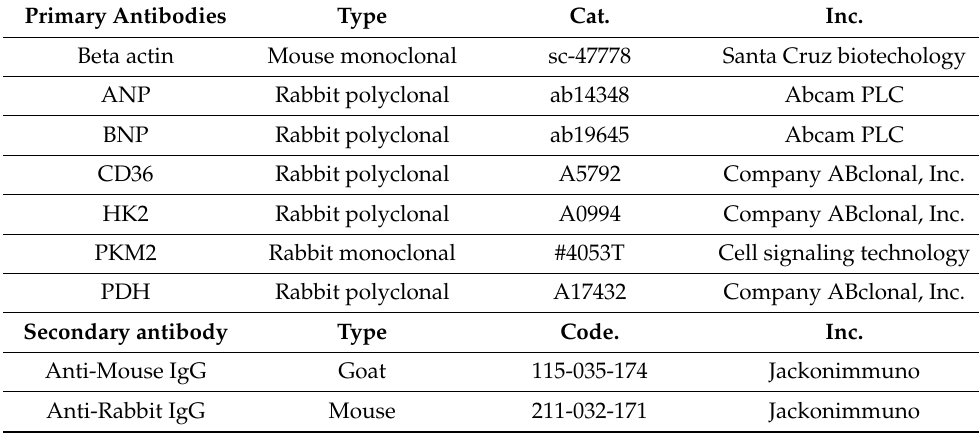
Table 1. Antibodies used for